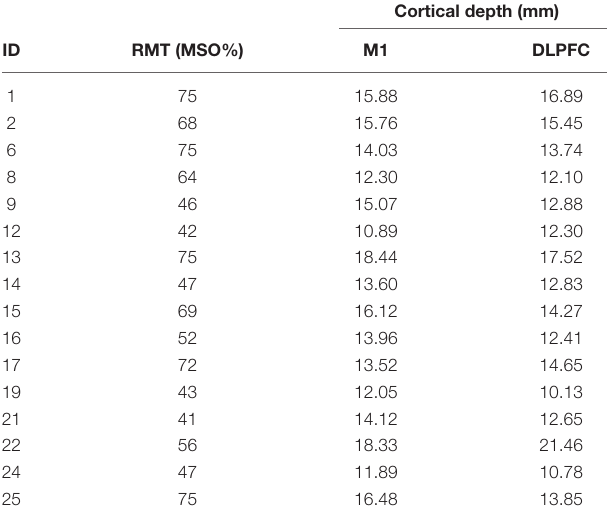
TABLE 1 | Overview of participant